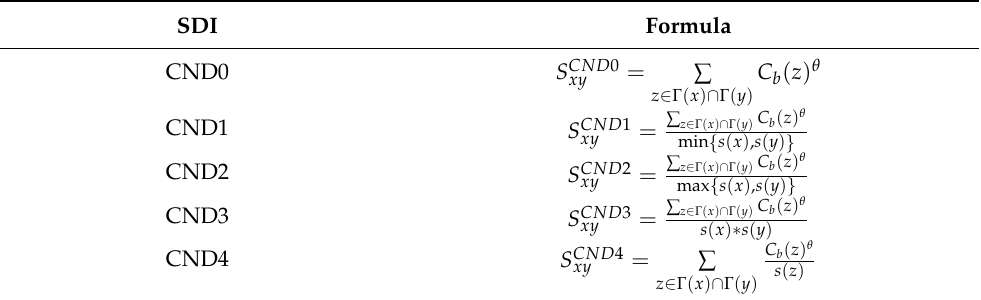
Table 1. SDI based on